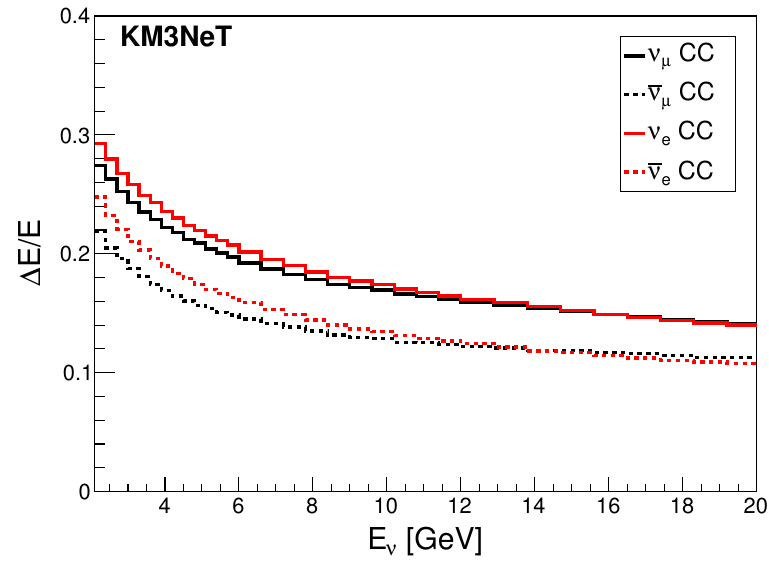
Figure 13 . Relative energy resolution (RMS) for (cid:23) (cid:22) (black solid), (cid:23) (cid:22) (black dashed), (cid:23) e (red solid) and (cid:23) e CC events (red